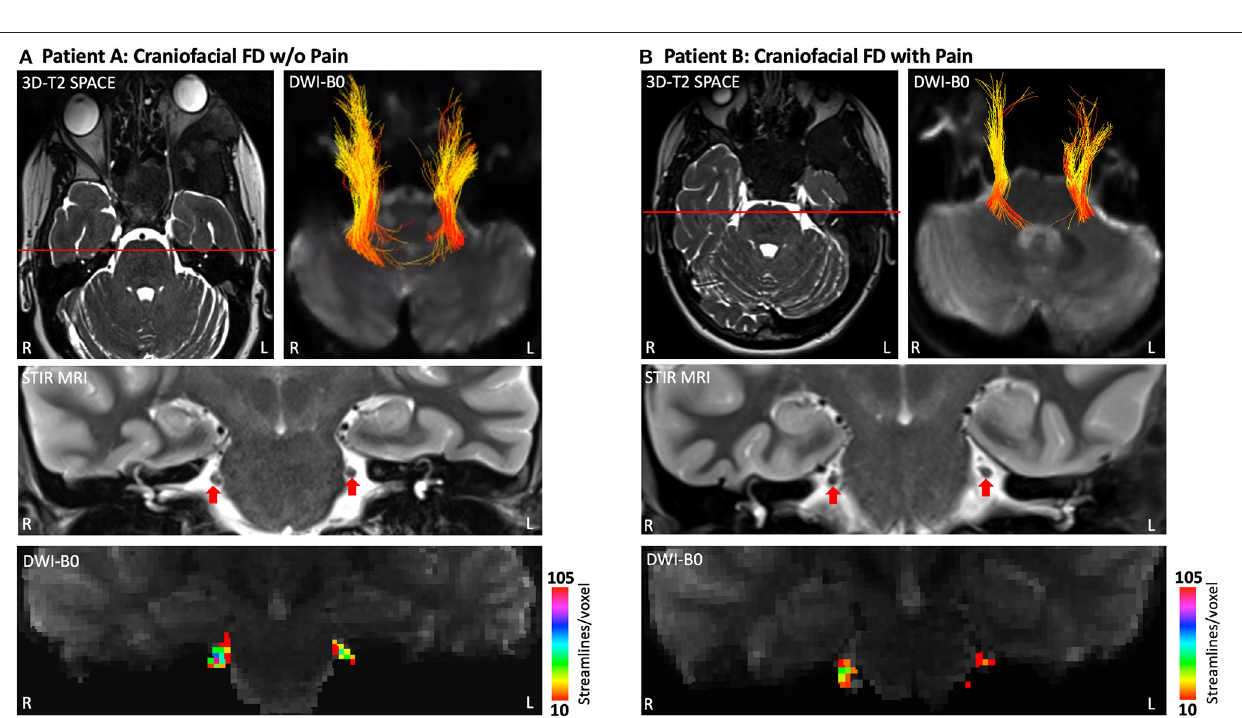
FIGURE 4 | Apparent fiber loss in the CNV (cisternal segment). Patient A (A) and Patient B (B) each demonstrated a lower level of apparent fiber density in left hemisphere CNV at the cisternal level as determined by diffusion MRI and tractography. Fiber streamlines projecting between the brainstem and trigeminal ganglion are shown colored by fractional anisotropy (FA). Coronal cross-sections of T2-SPACE MRI show normal caliber and symmetry of CNV for both patients. However, heat maps derived from diffusion tractography indicate a lower magnitude of streamlines per voxel (apparent fiber density) for the left hemisphere CNV, particularly for Patient B. Heat maps for the right hemisphere CNV indicate a lower level of streamlines per voxel in Patient B compared to Patient A. DTI data were collected using Human Connectome Project protocols (29). 3D-T2-SPACE, 3D-T2 Sampling Perfection with Application-Optimized Contrasts by Using Flip Angle Evolution; FA, Fractional Anisotropy; STIR MRI, Short Tau Inversion Recovery Magnetic Resonance Imaging; DWI, Diffusion Weighted Imaging.